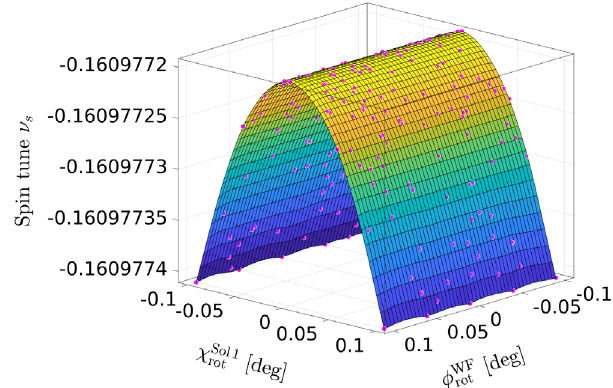
¼ rot Þ ; χ Sol 1 rot rot